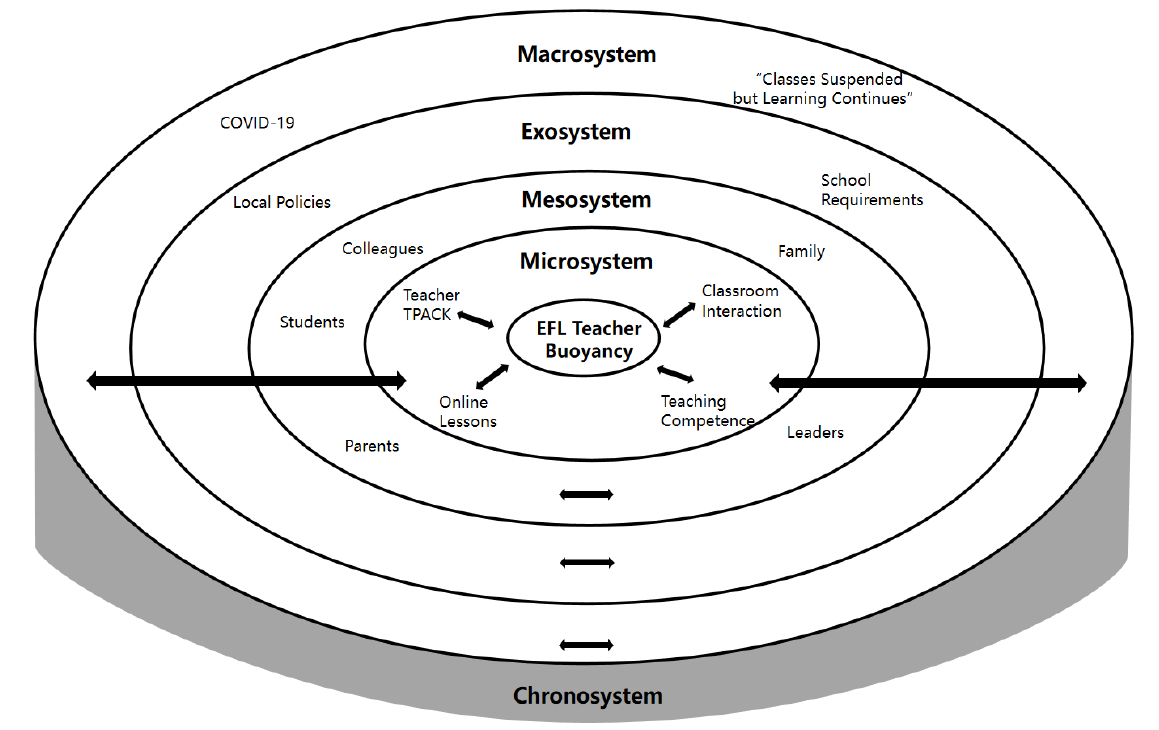
Figure 1. The nested ecological systems for EFL teacher buoyancy in the online teaching setting.